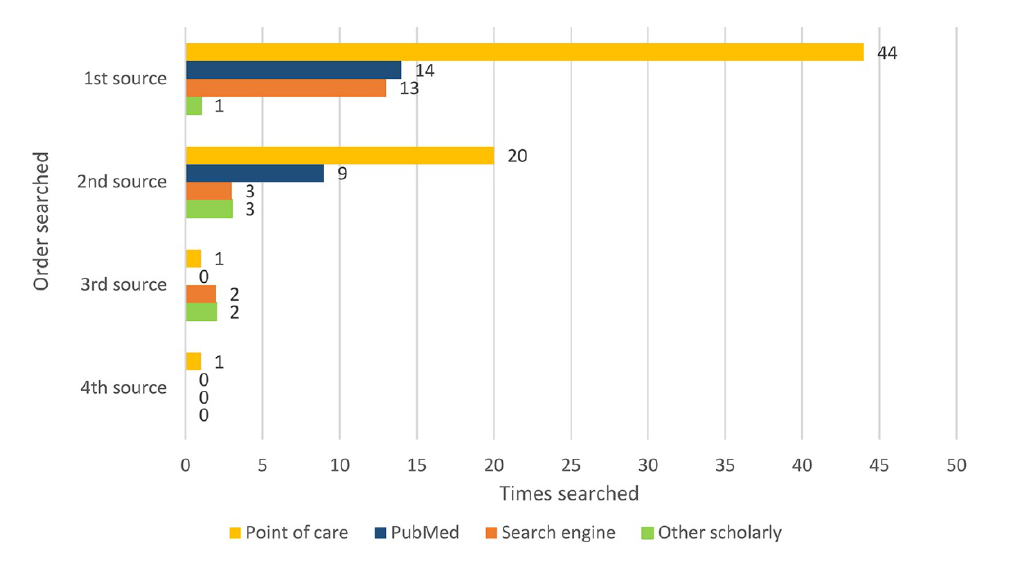
Figure 1 Types and order of information sources